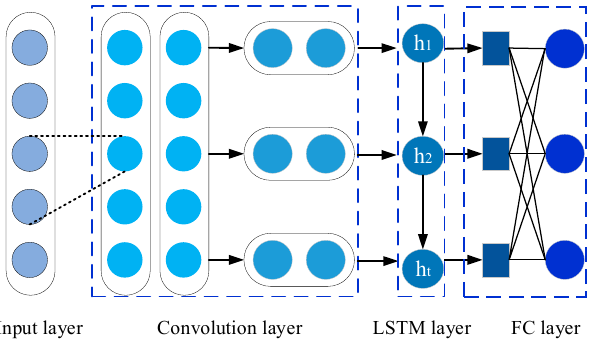
Figure 1. The structure of the proposed CNN-LSTM network .